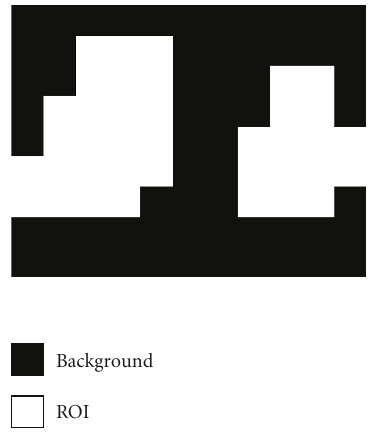
Figure 14: Slice group mapping (“Paris” sequence, t = 17 . 5